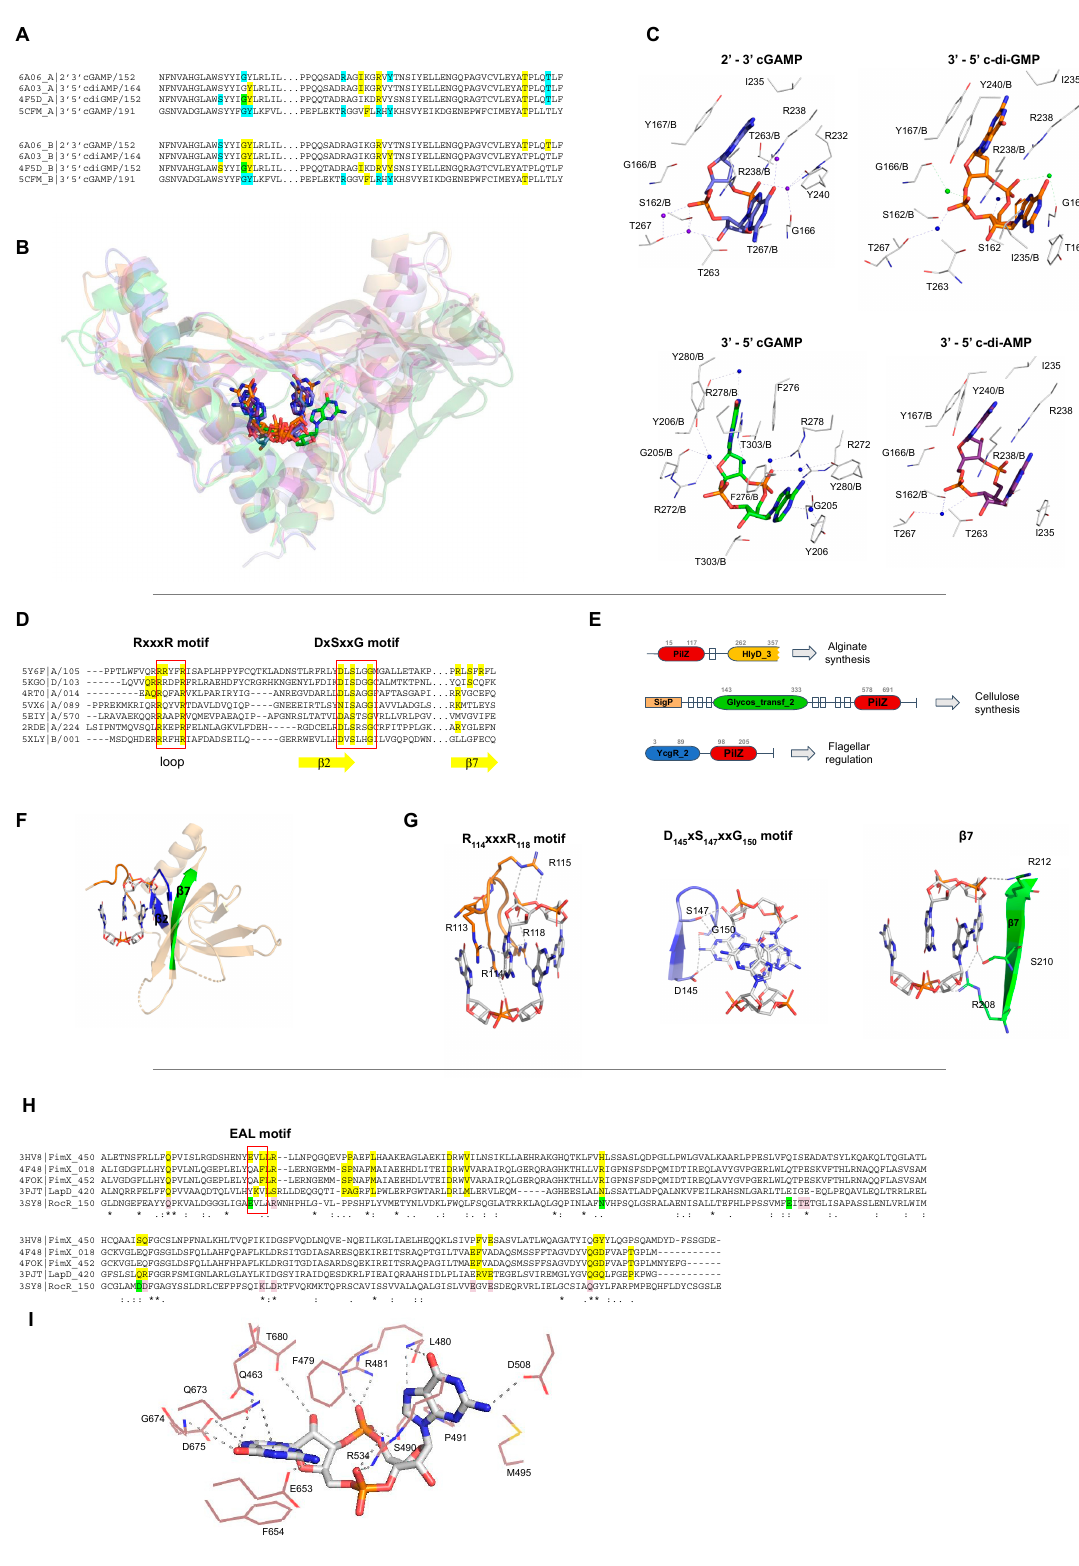
Figure 7. Some CDN receptors: STING, PILZ, and degenerate EAL domains. ( A ) multiple sequence alignment of STING proteins in complex with different CDNs: monomeric 3’-5’ c-di-GMP (PDBID: 4F5D), 2’-3’ cGAMP (PDBID: 6A06), 3’-5’ c-di-AMP (PDBID: 6A03), and 3’-5’ cGAMP (PDBID: 5CFM). The residues highlighted in yellow are involved with direct interaction with the ligand, those in green are involved with interaction with the ligand via magnesium ions, and those in cyan interact via